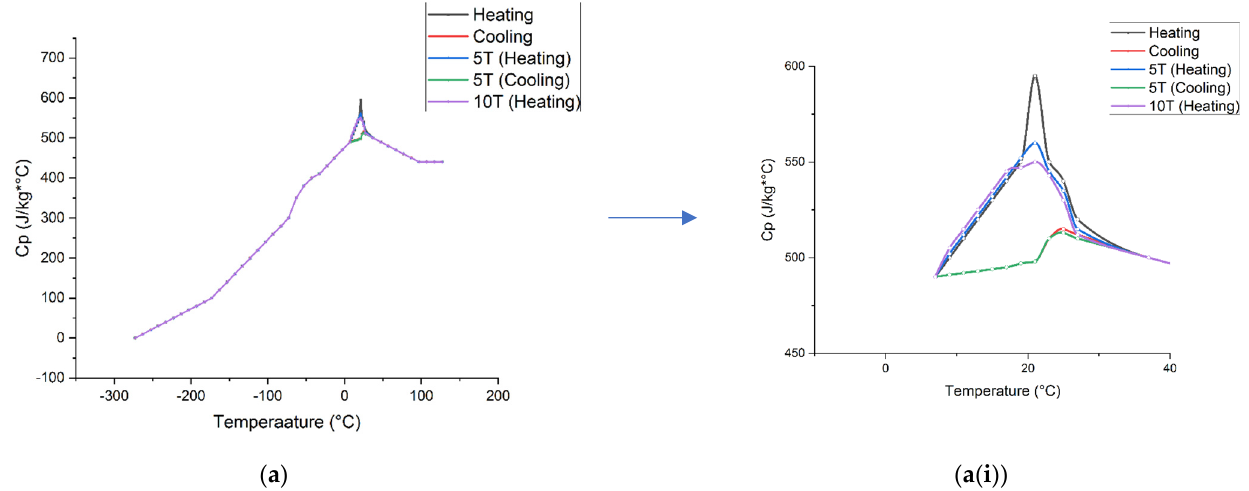
Figure 2. (a) Cp vs. temperature for alloy with Fe 4 concentration; ( a ( i )) represents the magnified